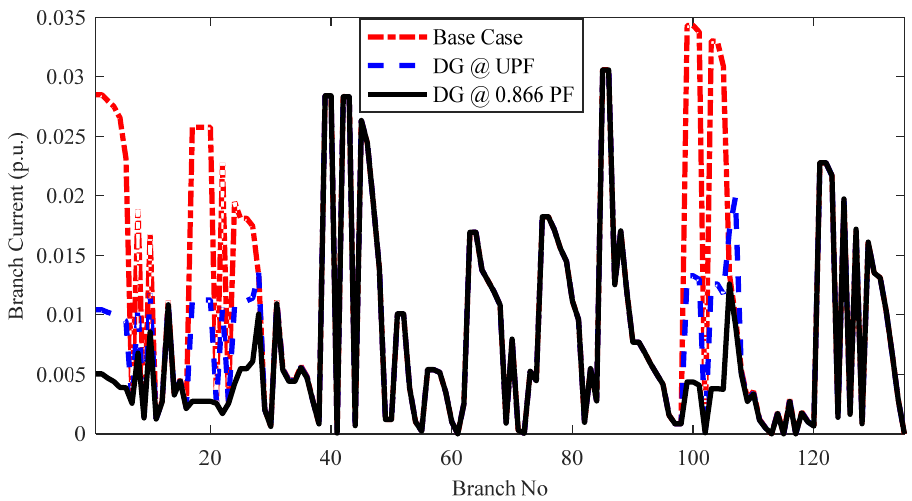
Figure 18. Voltage profile of the 136 bus test system for scenario IV.